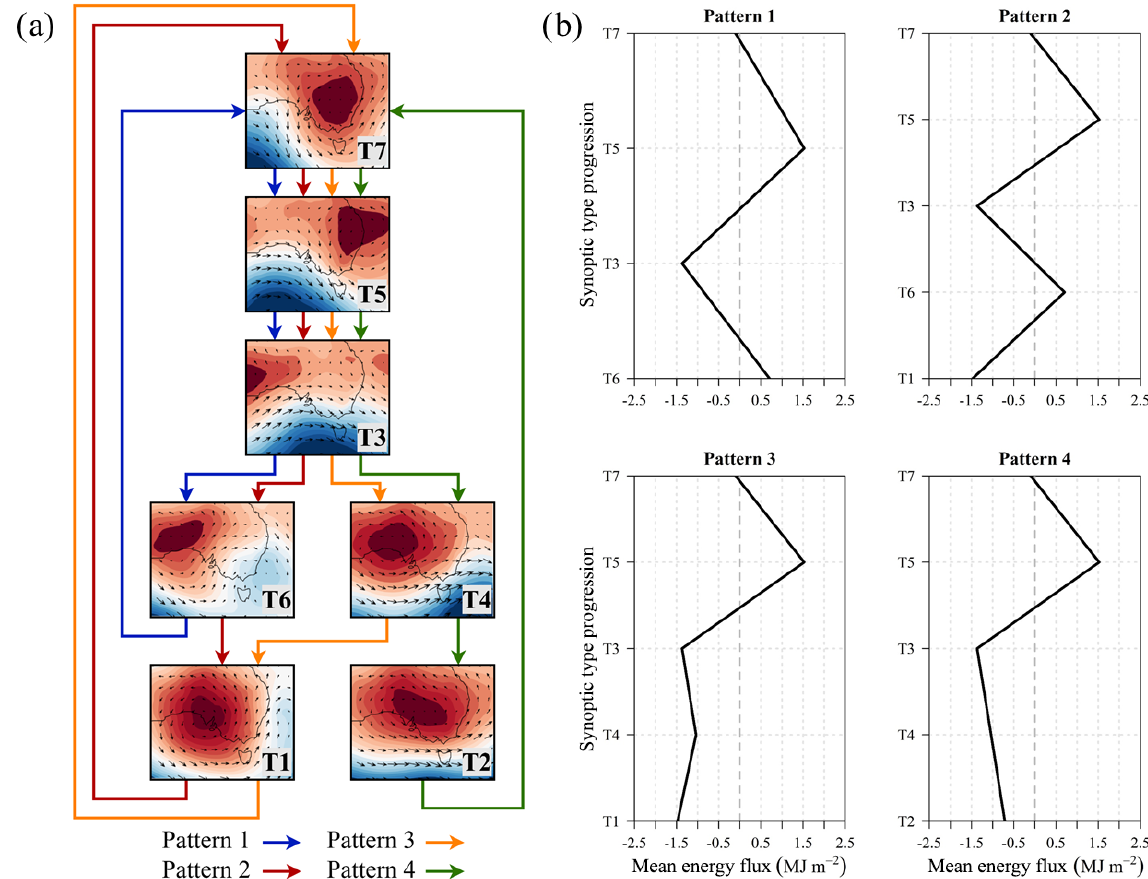
Figure 4. Flowchart of four primary synoptic type patterns/progressions based on probability of transition for the 2016 and 2017 seasons (a) and calculated synoptic pattern snowpack fluxes based on median daily values and mean duration of synoptic type (b)